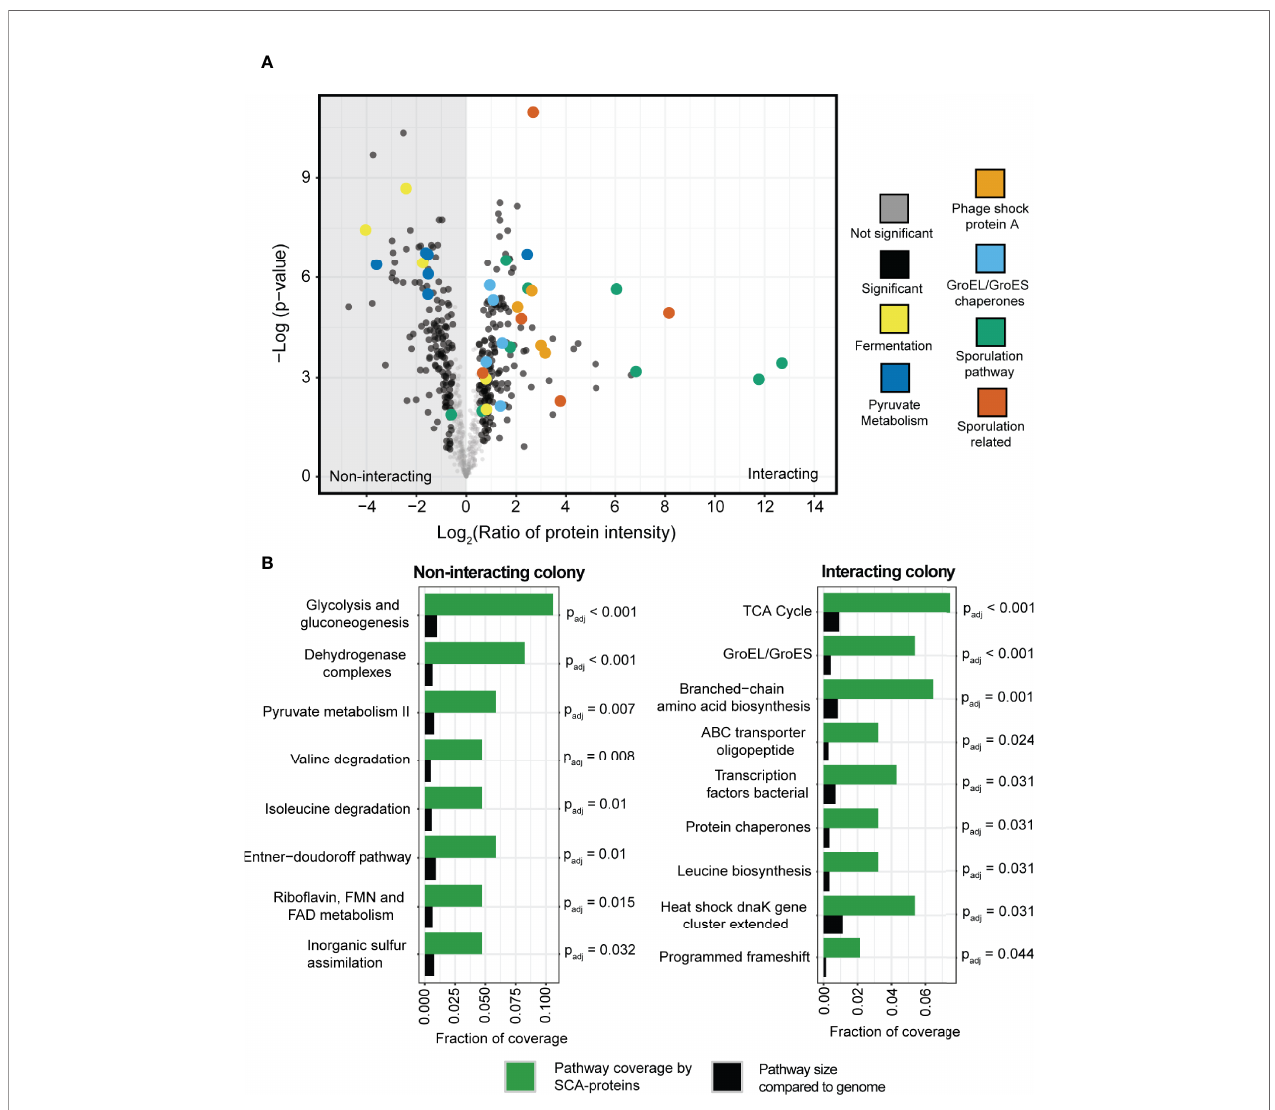
FIGURE 6 | Proteomics pro fi ling of the interacting and non-interacting colony of P. amylolyticus . (A) Volcano plot of the relative abundance of the proteins between the interacting and the non-interacting P. amylolyticus showed a signi fi cant change in the abundance of 328 proteins between the two states. (B) Identi fi cation of potentially regulated pathways between the two conditions. A Fishers Exact test was performed with Benjamini-Hochberg false discovery rate correction (threshold of Padj < 0.05) between pathway coverage with SCA-proteins belonging to the pathway (indicated in green bars) and the proportion of the pathway size in the genome (indicated with black